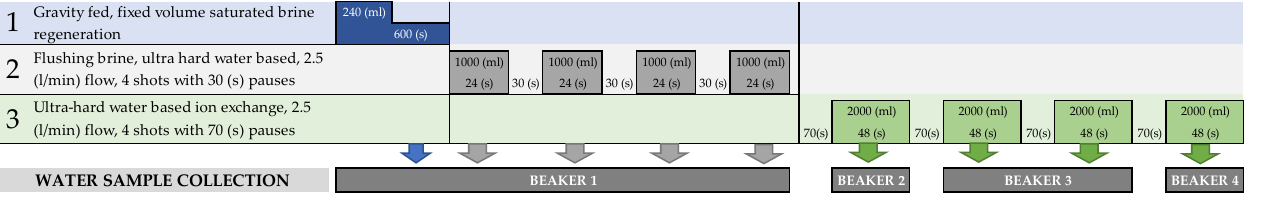
Figure 6. Resin test product’s timing, solution volumes, and operation logic used in the study. After regeneration, four softening cycles took place. All the softening cycles consisted of 2 L of 70 dH water, flushing the resin with a 2.5 L/min fixed flow. Beginning with a 70 s pause, consecutive softening cycles followed. The water from all the softening cycles was contained in a mixed buffer zone, from which 100 mL samples were taken in the following order: 100 mL was drawn from the first cycle to the second beaker, the second and third cycles were mixed for an averaged 100 mL third beaker sample, whereas the fourth cycle was sampled (100 mL) to the fourth beaker in the row.